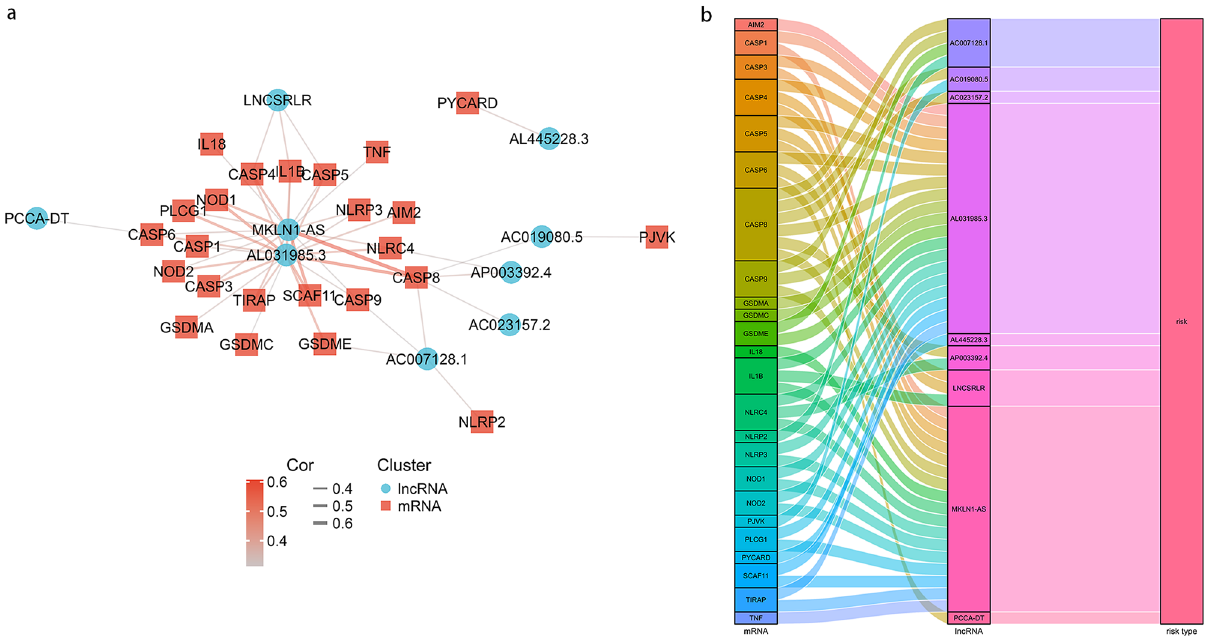
Figure 3. The mRNA-lncRNA co-expression network. ( a ) mRNA-lncRNA co-expression network of the pyroptosis-related genes and the selected pyroptosis-related lncRNAs. ( b ) The Sankey diagram showing the connection degree between the pyroptosis-related lncRNAs and the pyroptosis-related